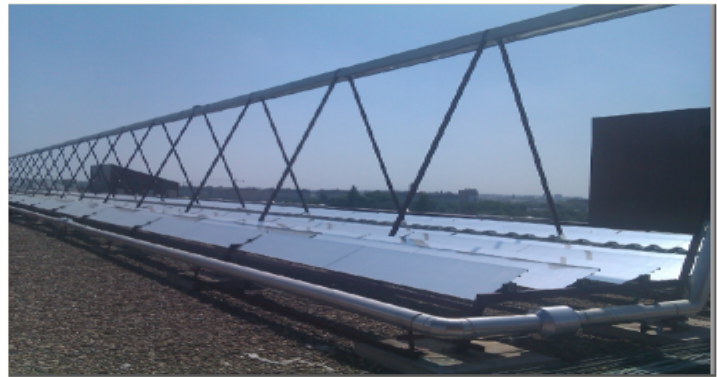
Figure 2. Fresnel collector